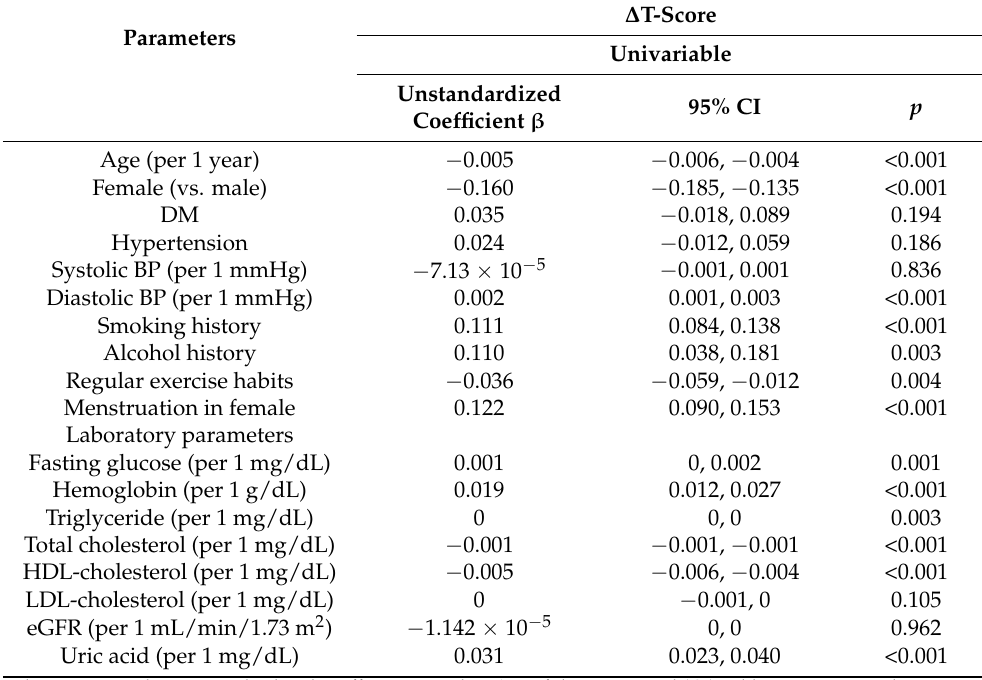
Table 5. Determinants of ∆ T-score using univariable linear regression analysis.